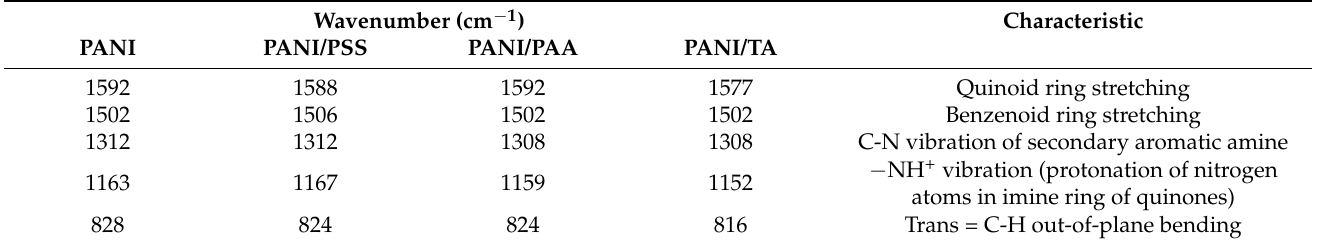
Figure 4. ( a ) FTIR spectra, ( b ) the ratio of quinoid to benzenoid peaks, ( c ) Nyquist plot, ( d ) conduc- tivity value of doped PANI films. Table 1. The associated peaks of the FTIR spectra from Figure 4 and the conductivity data.